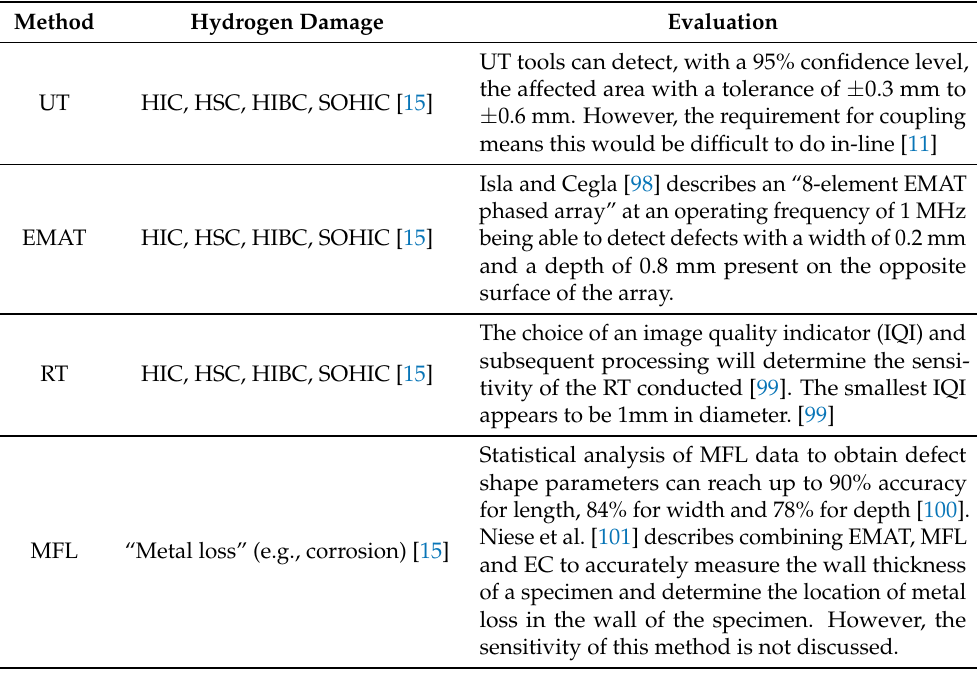
Table 8. An evaluation of the discussed NDE methods in relation to the hydrogen damage that they can